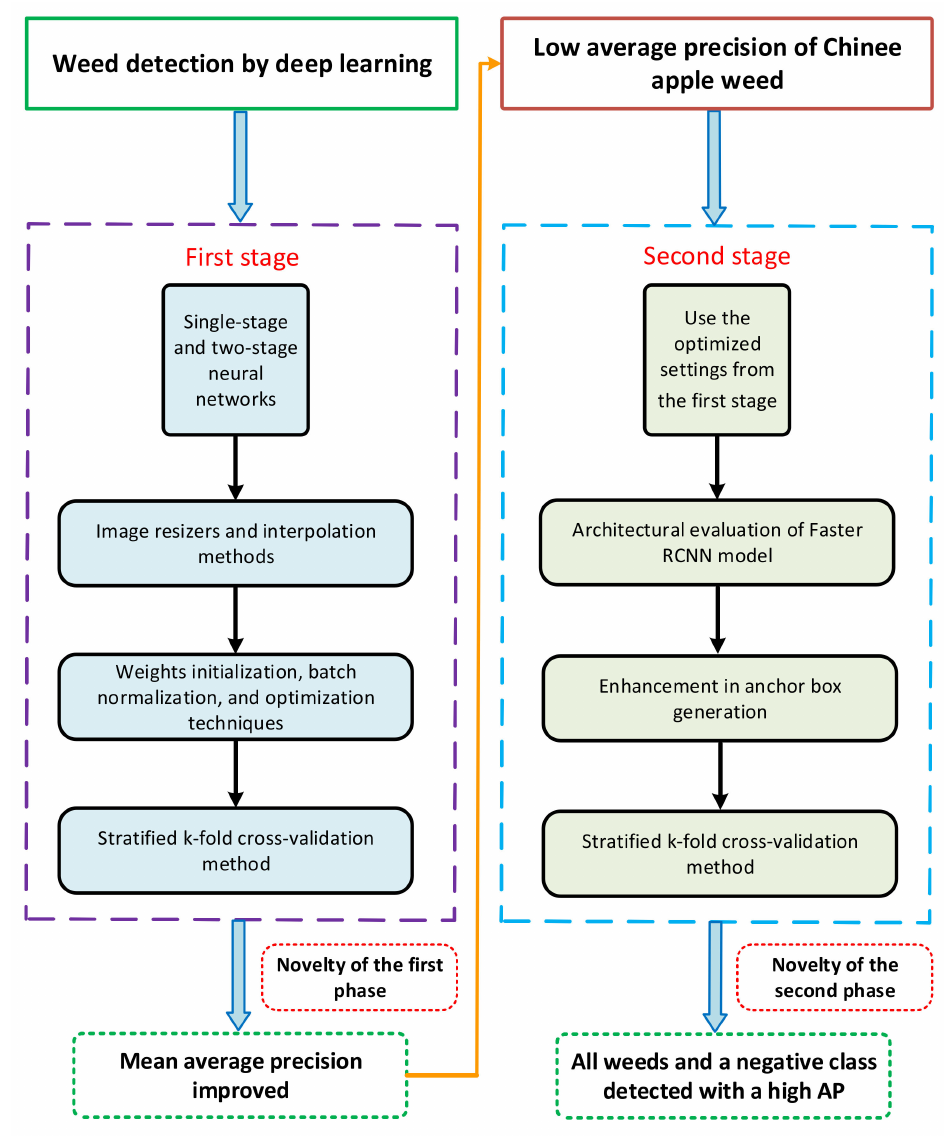
Figure 1. The overall methodology of the two-step DL-based weed